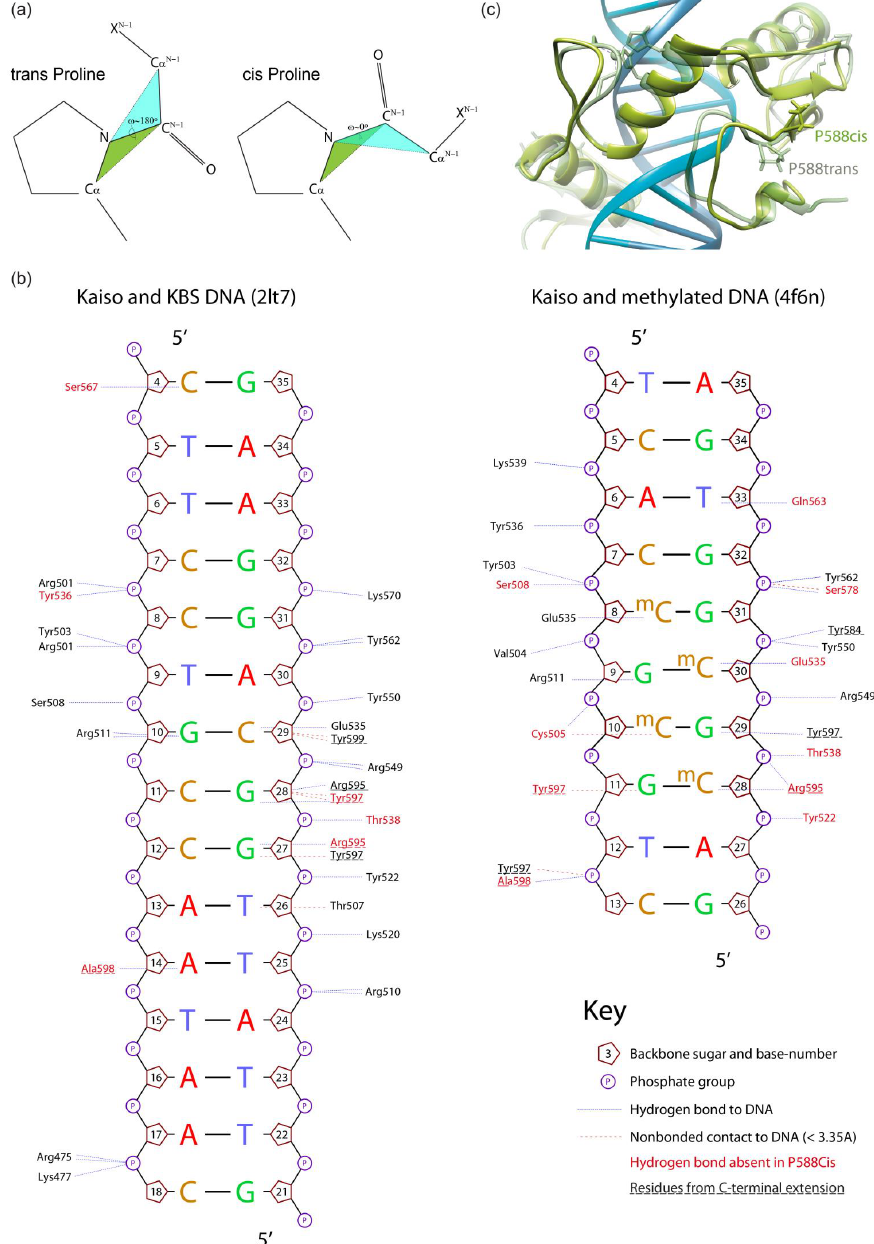
Figure 2. Comparison of 100 ns molecular dynamics simulation of wild-type and P588-altered Kaiso–DNA complexes (based on the PDB:2LT7 NMR structure of Kaiso with unmethylated DNA). ( a ) Schematic representation of cis- and trans-proline conformations. ( b ) Schematic representation of the effect of P588 trans to cis isomerization on the hydrogen bonds formed by Kaiso protein with Kaiso binding sequence or methylated DNA. Plots were drawn for initial structures using Nucplot [33]. ( c ) Overlay of wild-type and P588 cis Kaiso–DNA